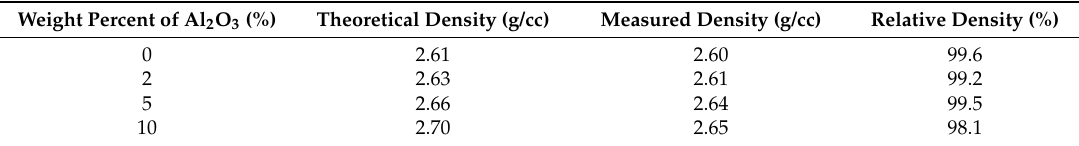
Figure 3. XRD analysis of Al-12Si/Al 2 O 3 nanocomposites with ( a ) 0, ( b ) 2, ( c ) 5, and ( d ) 10 wt. % addition of Al 2 O 3 reinforcement.